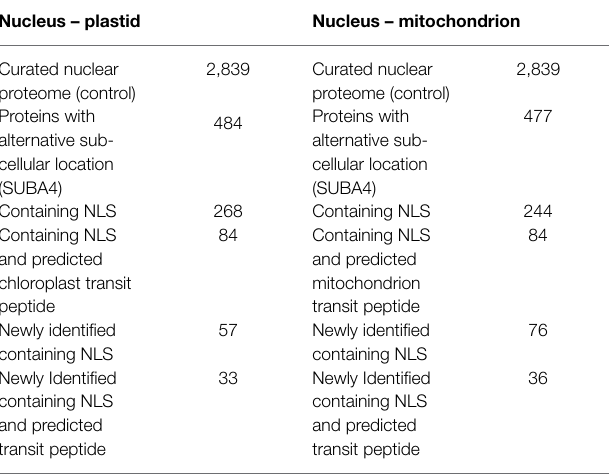
TABLE 1 | Putative dual targeted proteins (found in both